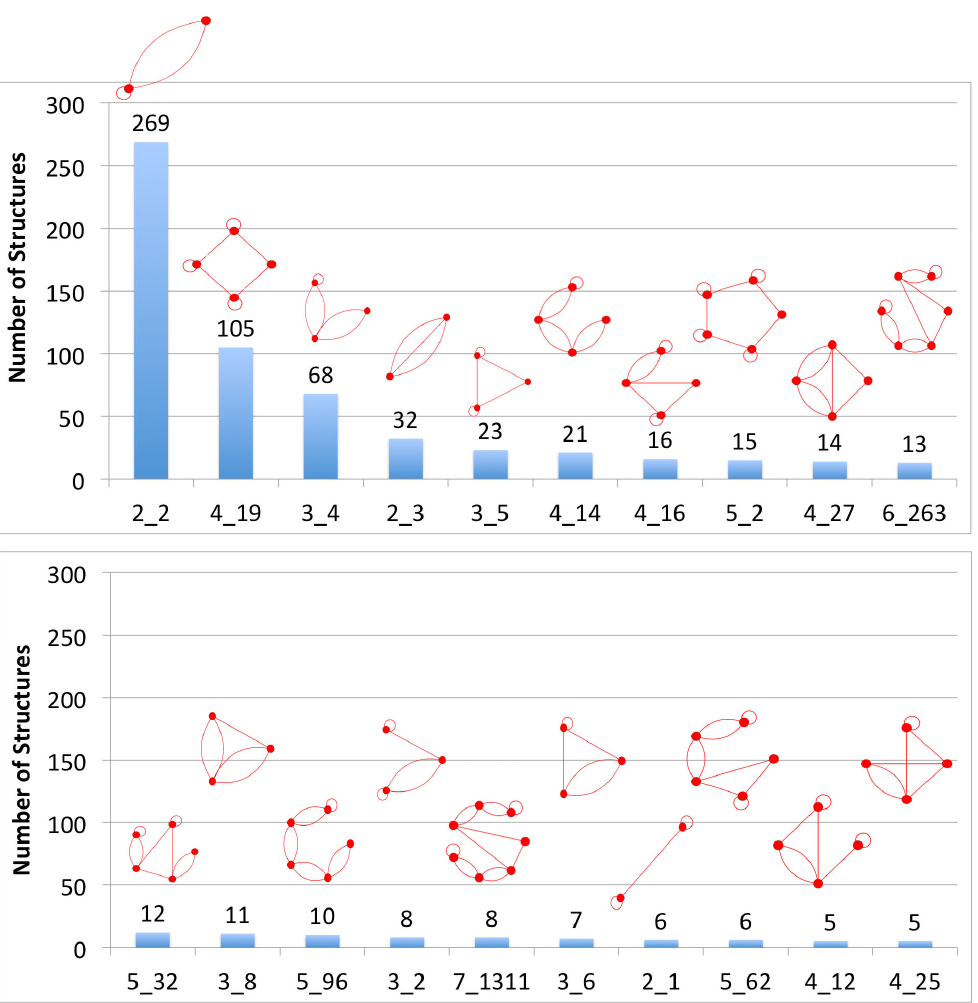
Figure 3. Common existing dual graph topologies. Existing dual graph IDs with five or more structures in the representative dataset of RNA structures are shown. See Table S1 in the Supplementary data for complete details of all 94 existing dual graph